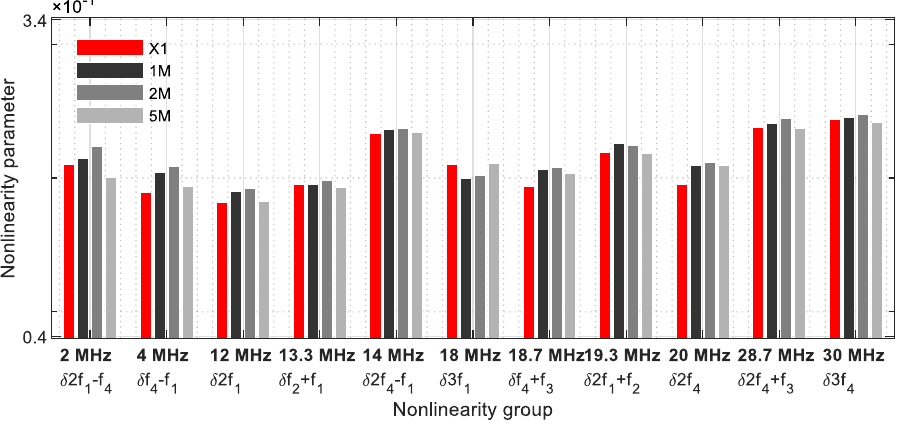
Figure 21. Nonlinearity parameter — δ G1 .